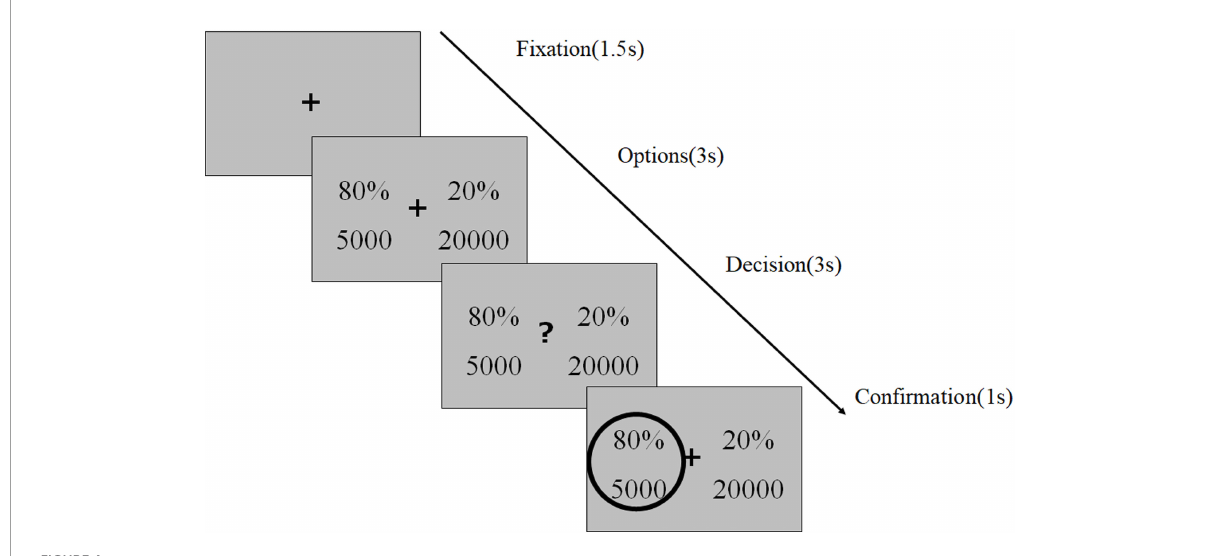
FIGURE4 Experimental design of the risk-based decision-making